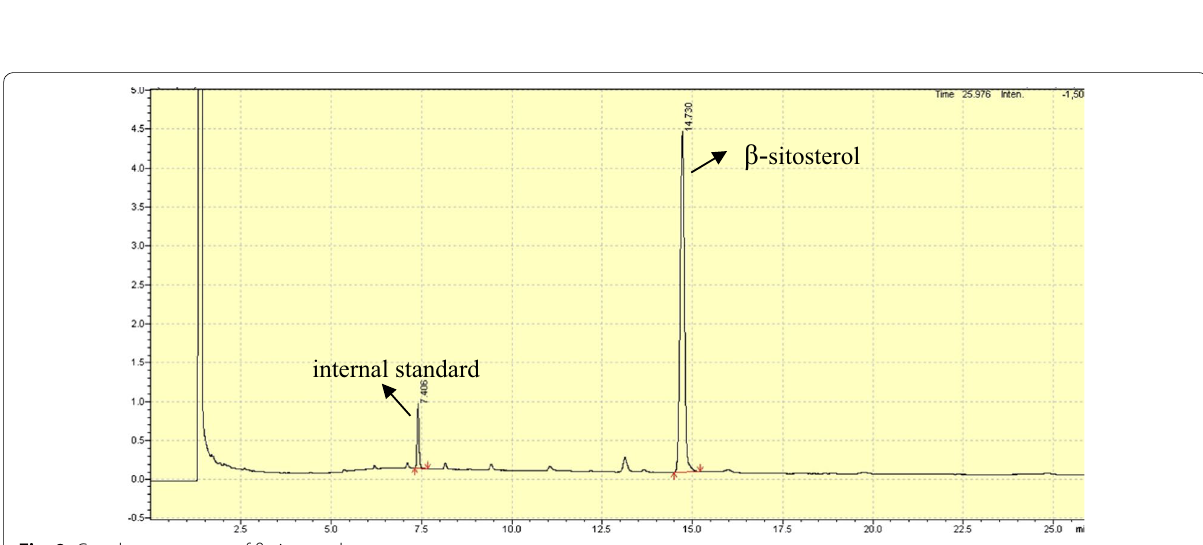
Fig. 9 Gas chromatogram of